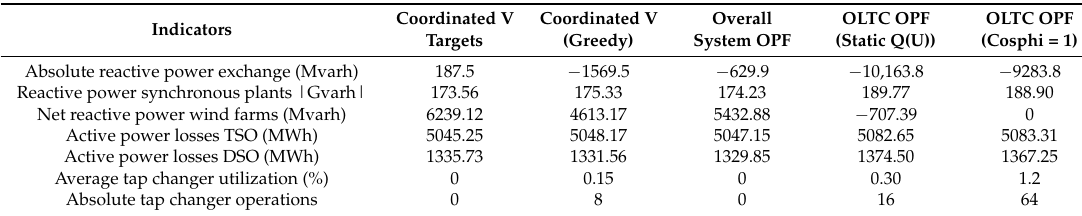
Table 6. Weekly performance.